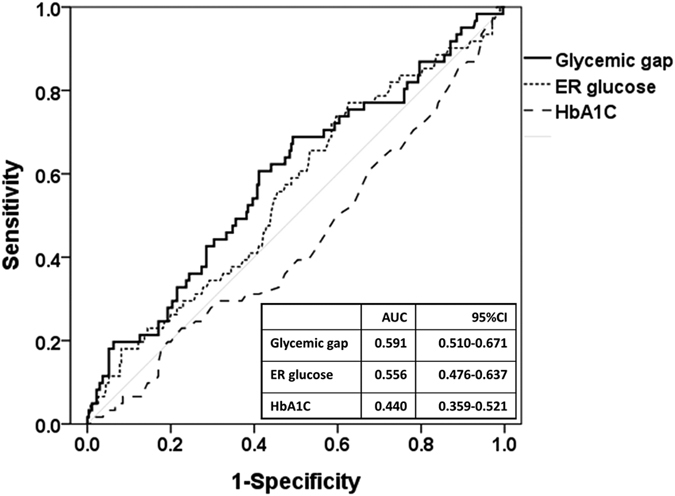
ROCs for acute hyperglycemia, chronic blood glucose control, glycemic gaps, and adverse outcomes in diabetic patients presenting to the emergency department with acute myocardial infarction.AUROC: area under the curve; ROC: receiver operating characteristic.